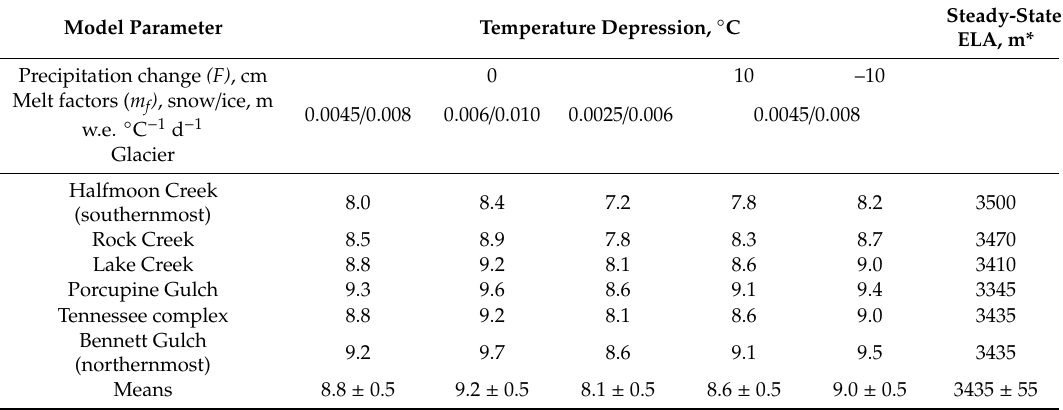
Table 4. Derived temperature depressions and ELAs based on steady-state mass balance of paleoglaciers. Temperatures are reported to the nearest tenth of a